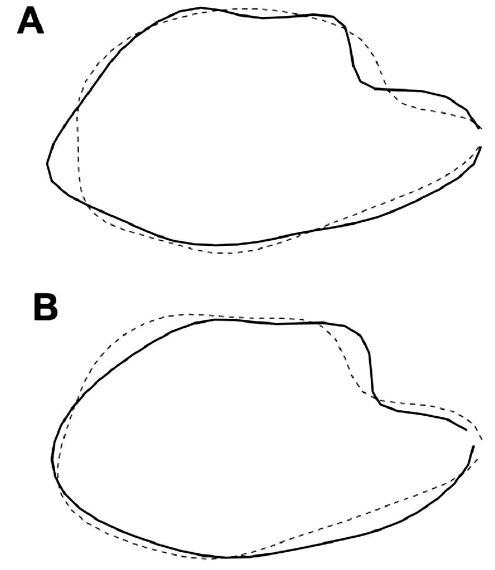
Fig. 6. – Extreme shape variation of otolith outline as explained along maxima and minima scores along the first PC (A) and second PC (B).